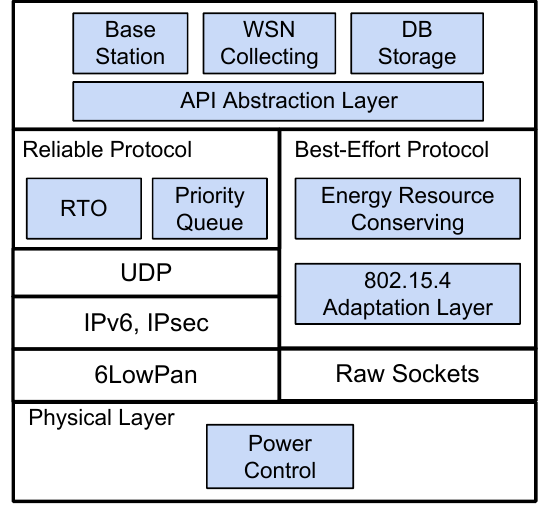
Figure 1. Dual-Stack Single-Radio Communication Architecture (DSSRCA) overview: customized transport layer on top of 6LoWPAN ( left ) and the small-footprint Wireless Sensor Network (WSN) protocol ( right